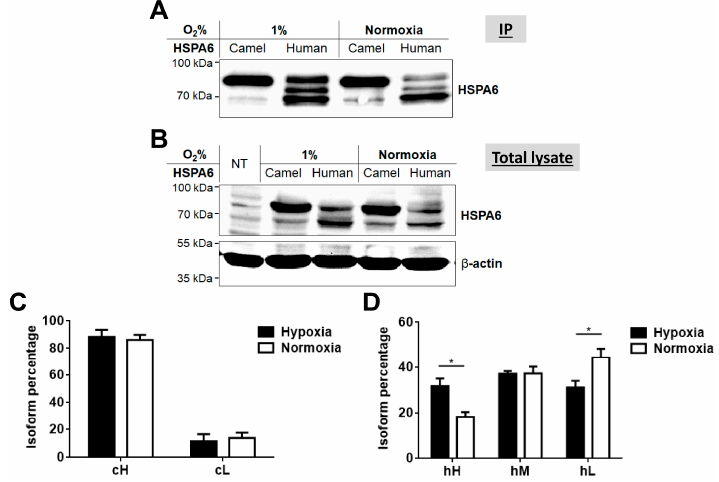
Figure 5. Response of camel and human HSPA6 isoforms to different oxygen concentrations. ( A ) 24 h after transfection, cells were cultured under normal or 1% oxygen levels for 15 h followed by immunoprecipitation of HSPA6 and Western blotting; ( B ) The loading controls for (A) utilized equal amount of proteins in lysates of transfected COS-1 cells; ( C , D ) Quantification of each camel or human HSPA6 isoform in the total protein isoforms after incubation under hypoxic or normoxic conditions. As described in Figure 4, camel HSPA6 is identified by two isoforms (higher (cH) and lower (cL)), while human HSPA6 exhibits three isoforms (higher (hH), middle (hM) and lower (hL)). Statistically significant values are denoted by an asterisk and the blots are representative data sets out of five independent repeats.